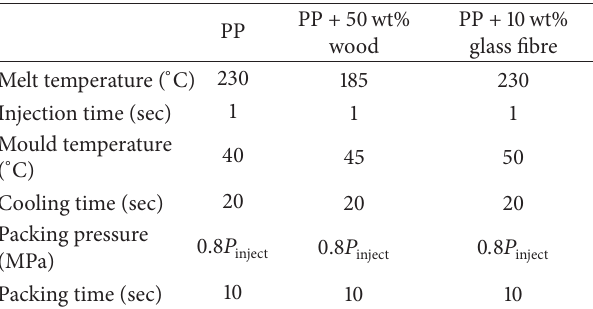
Table 3: The processing parameter